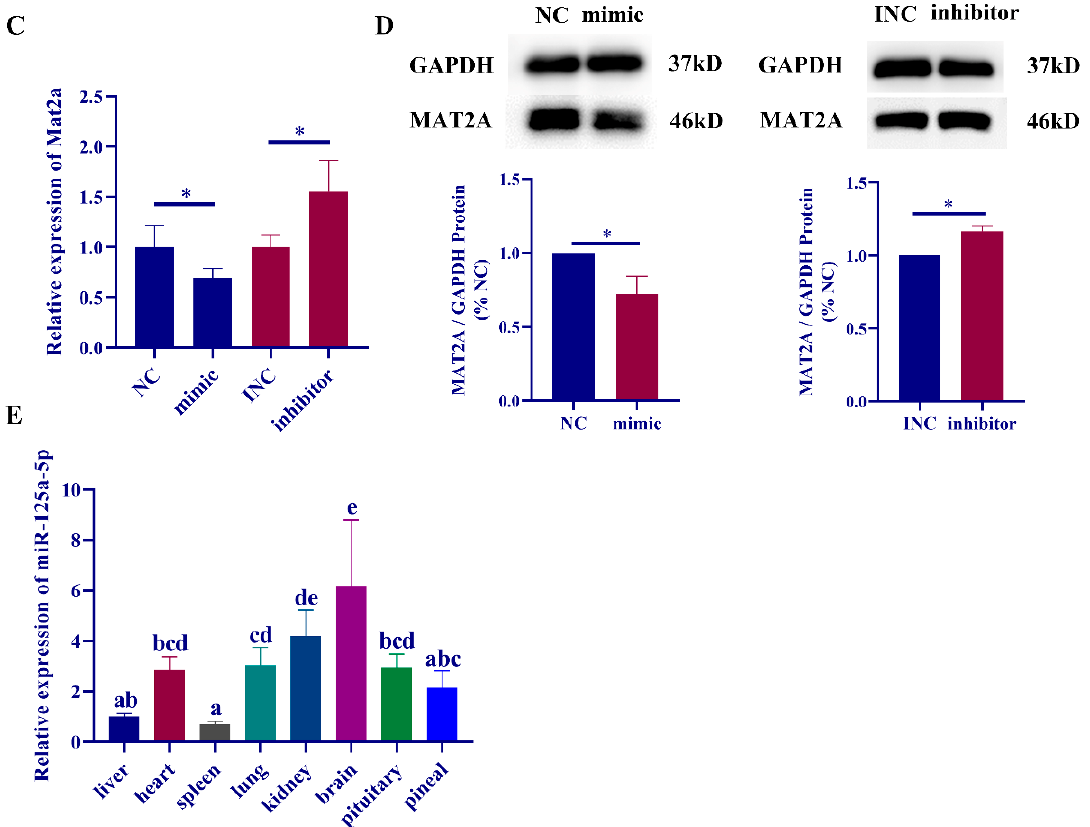
Figure 3. miR-125a-5p binds to mat2a mRNA 3 (cid:48) -UTR and inhibits MAT2A expression. ( A ) Relative expression of miR-125a-5p in the pineal gland of rats during the day and night. ( B ) Dual luciferase reporter assay results for miR-328a-3p, the wild-type mat2a mRNA 3 (cid:48) -UTR. ( C ) Relative expression of mat2a mRNA after transfection with miR-125a-5p mimic/inhibitor. ( D ) Relative expression of MAT2A protein after transfection with miR-125a-5p mimic/inhibitor. ( E ) Relative expression of miR-125a-5p in different tissues of rats. The letters (a, b, c, d, e) mean there are significant differences among them. *, p < 0.05. NC means miR-125a-5p mimic-NC and INC means miR-125a-5p